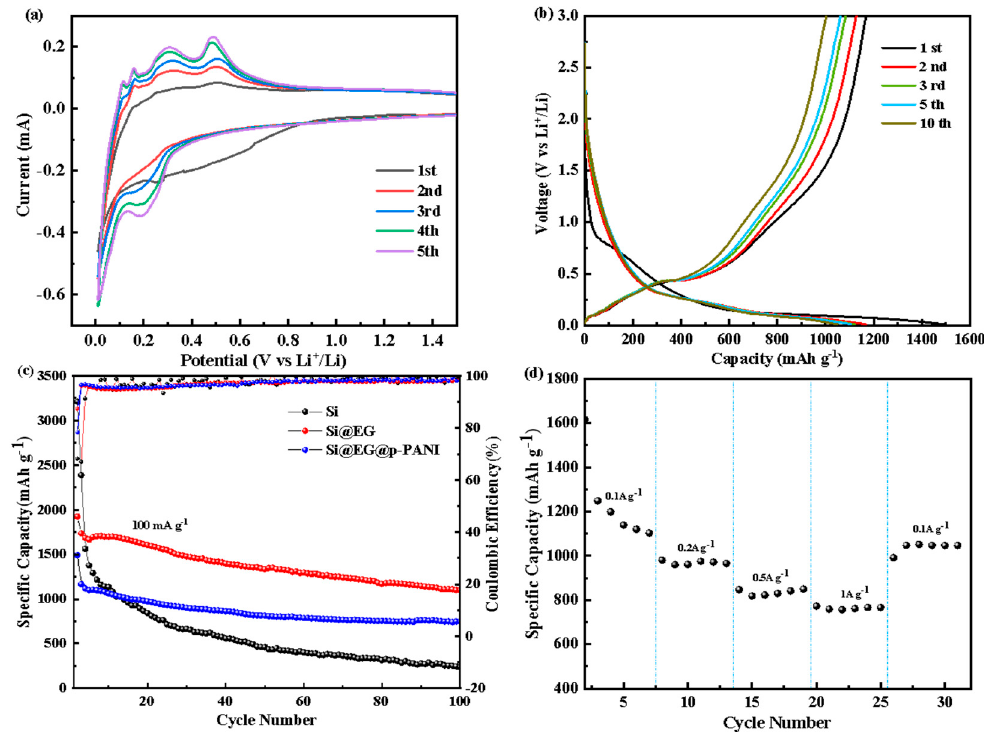
Figure 5. ( a ) Cyclic voltammetry curves of Si@EG@p − PANI from cycles 1 to 5 at a scanning rate of 0.1 mV s − 1 . ( b ) Galvanostatic charge − discharge profiles at a current density of 100 mA g − 1 in the voltage range of 0.01 − 3 V. ( c ) Cycling performances and coulombic efficiency of Si@EG@p − PANI, Si@EG and nano-Si electrode at a current density of 100 mA g − 1 . ( d ) Rate capabilities of Si@EG@p − PANI at current densities from 0.1 to 1 A g − 1 .